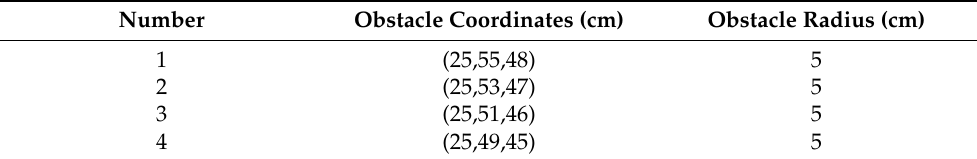
Table 4. Obstacle